Question: Describe this figure in one sentence.
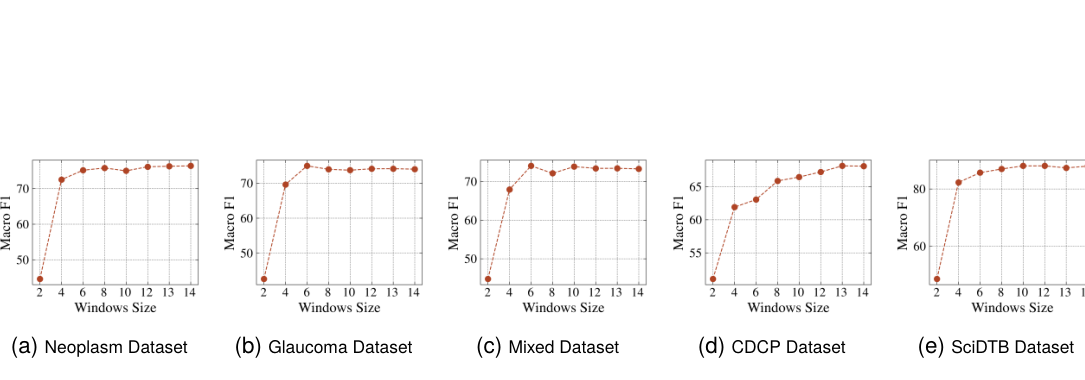
Answer: Macro-F1 scores when changing window size of contextual arguments.